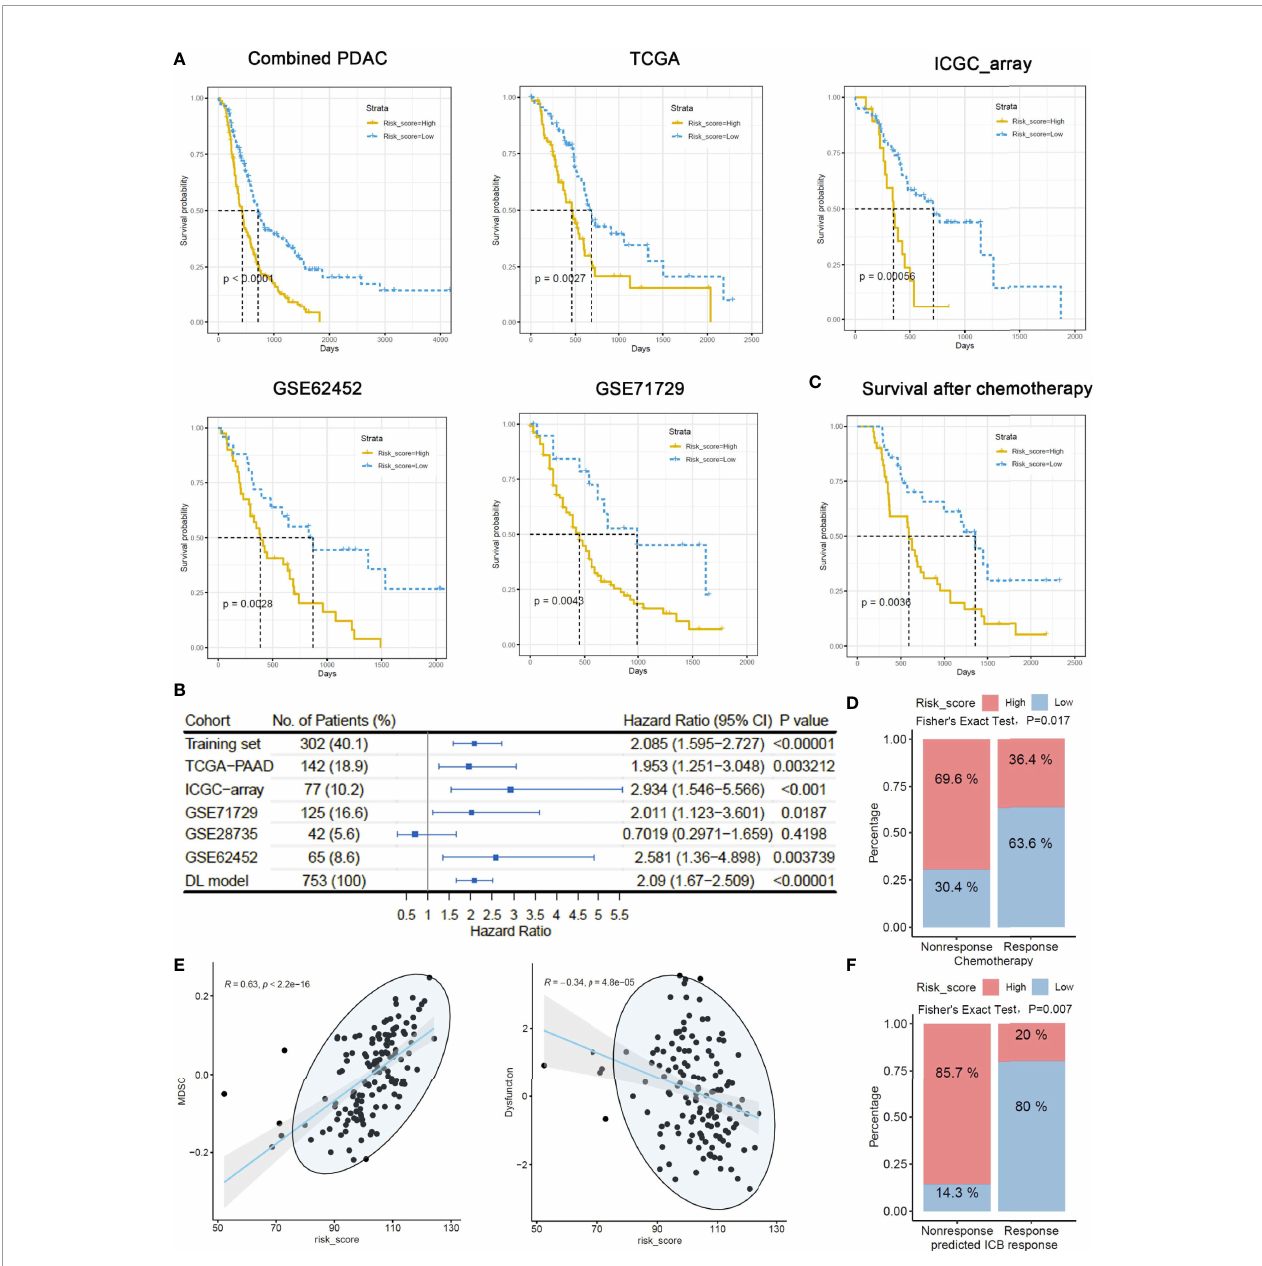
FIGURE 4 | MEMG-based risk score infers therapy ef fi ciencies in pancreatic cancer patients. (A) A risk score algorithm based on the expression pattern of MEMGs was established in a combined PDAC (training) dataset and tested for its prognostic relationship in the multiple testing sets. (B) The HRs of risk scores in different PDAC datasets were shown, and a meta-analysis with the DL model was performed to estimate the overall effect. (C) A Kaplan – Meier plot shows the correlation of the risk score with PDAC patients ’ survival after chemotherapy, tested by the log-rank test. (D) Correlation between risk score levels and actual responses. The signi fi cance was tested by Fisher ’ s exact test. (E) Scatterplots show the correlation of risk score with the TIDE-calculating MDSC abundance and dysfunction level. Correlations were analyzed by the Spearman method. (F) Associations of the risk score with TIDE-estimating immune checkpoint blockage therapy effectiveness. The signi fi cance was tested by Fisher ’ s exact